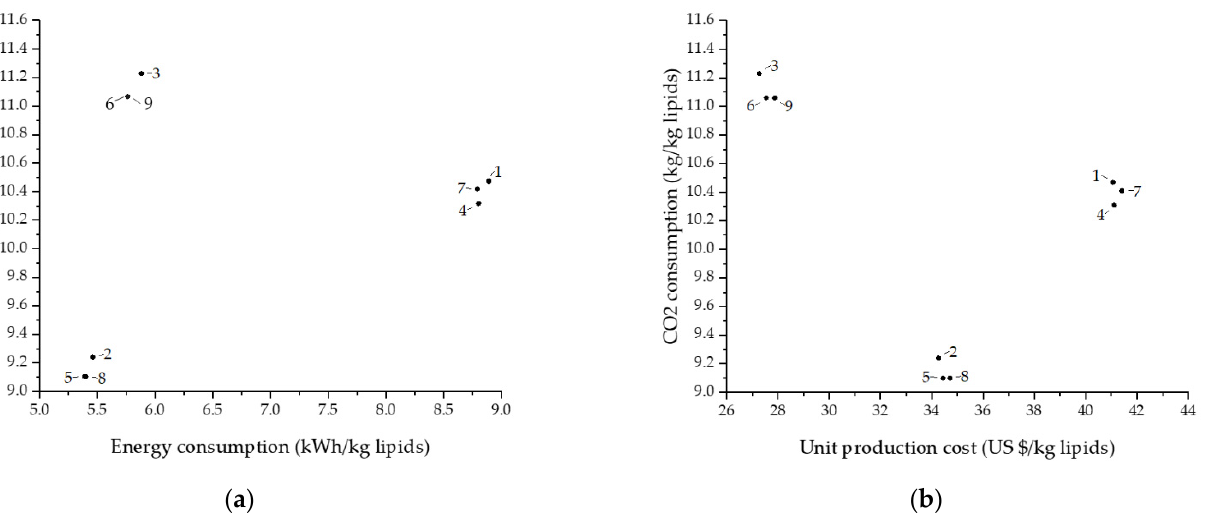
Figure 11. CO 2 consumption in the scenarios analyzed for lipid production: ( a ) Energy consumption vs. CO 2 consumption; ( b ) unit production cost vs. CO 2